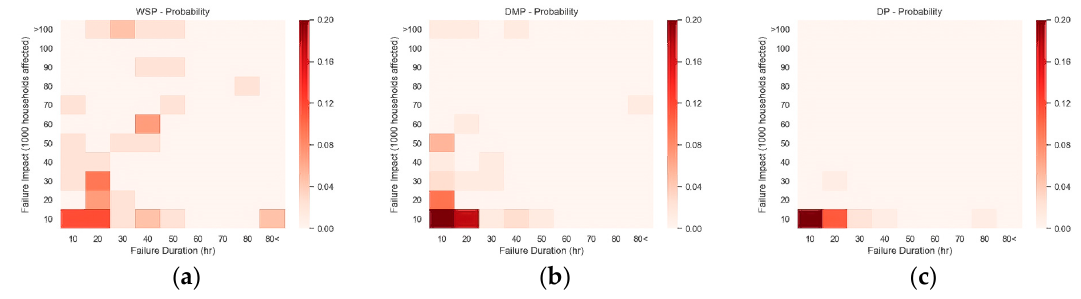
Figure 6. Individual ID response surface for different failures: ( a ) WSP, ( b ) DMP, and ( c ) DP.